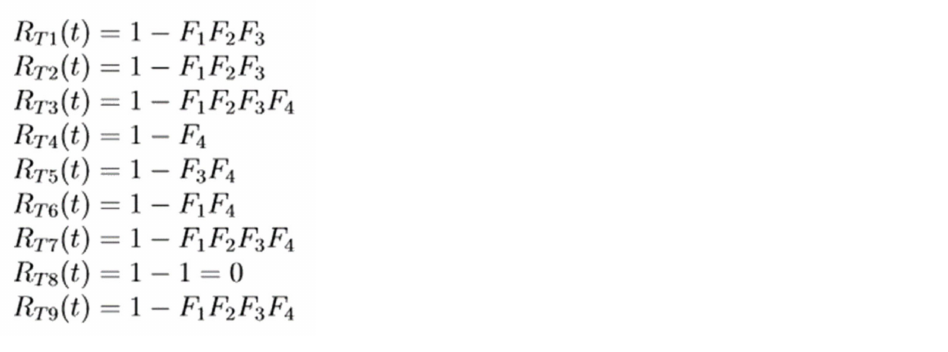
Figure 27. System Reliability Functions for each element in the SRM of the example